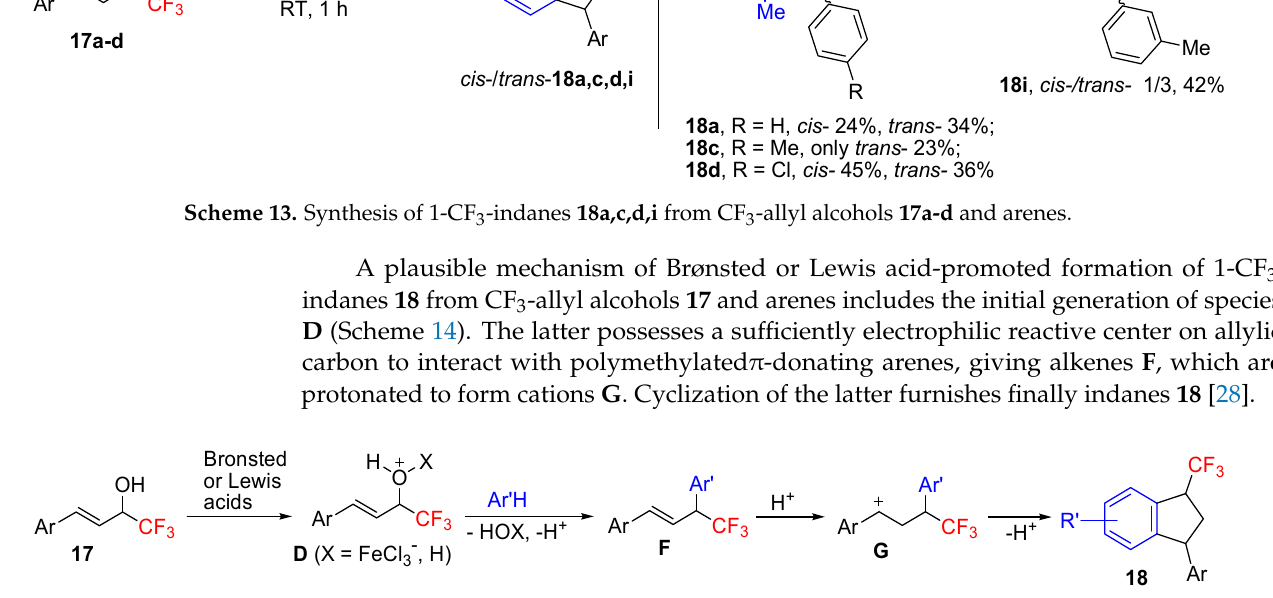
Scheme 14. Possible mechanism of acid-promoted formation of 1-CF 3 -indanes 18 from CF 3 -allyl alcohols 17 and arenes.